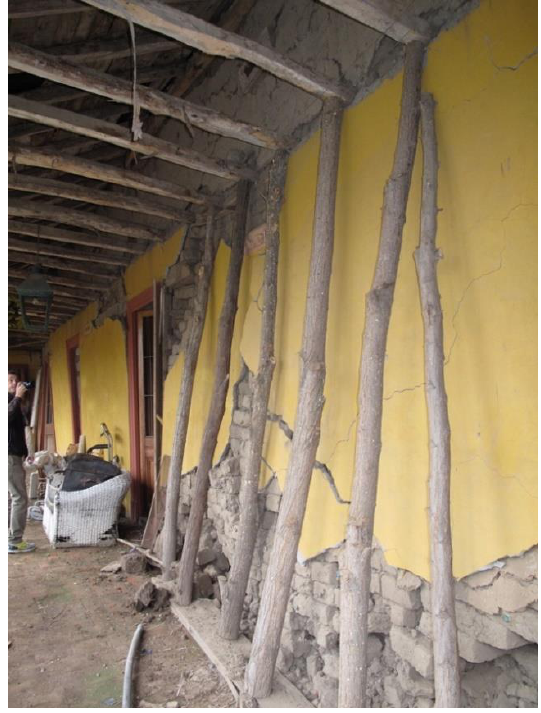
Figure 2. 2010 Chile Earthquake.